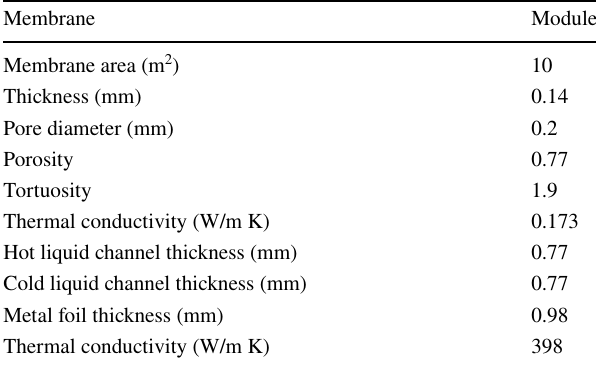
Table 1 Lists of membrane parameters and solar